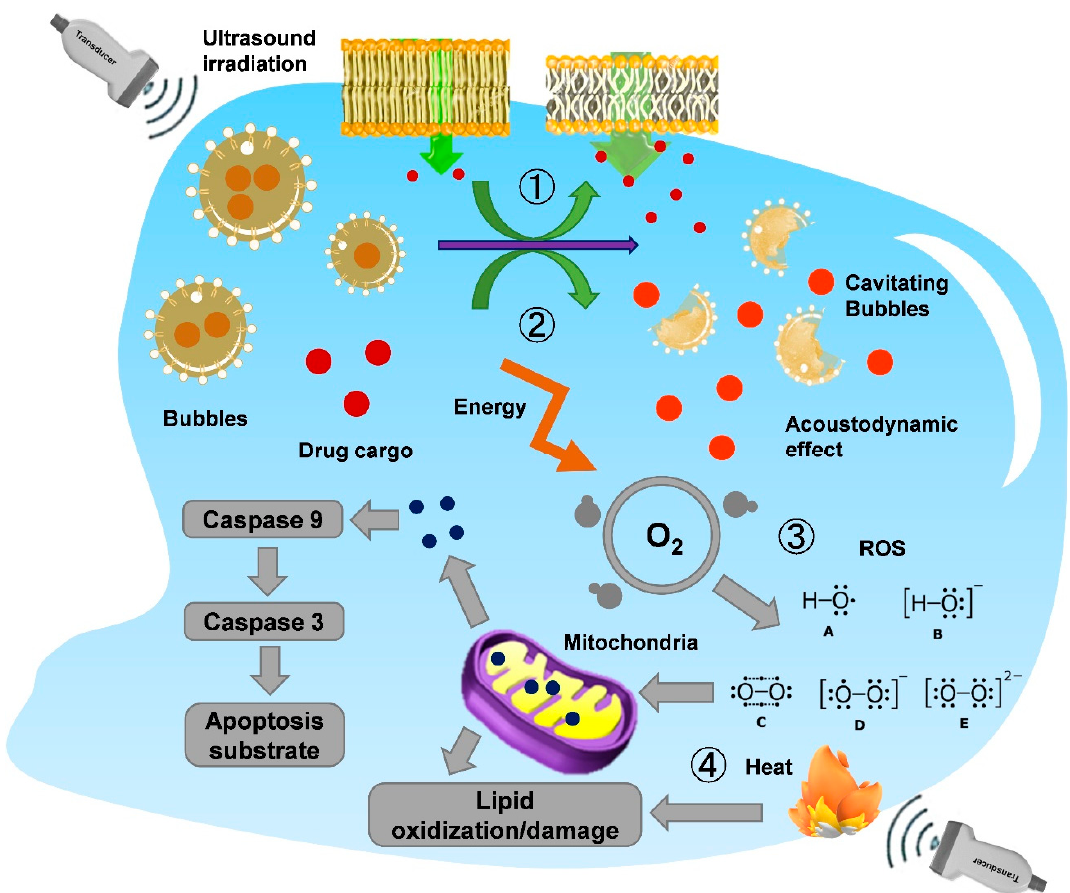
Figure 6. Schematic diagram of the various cellular change mechanisms induced by ultrasound. ① Cavitation caused by ultrasonic waves induces the rupture of bubble contrast agents in cells. ② Drug cargo is released, and acoustically powered drug delivery is provided. ③ Intracellular reactive oxygen species (ROS) may also be involved in cytotoxicity due to ultrasound excitation and generation. ROS-mediated mitochondrial membrane damage and the release of cytochrome c induce apoptosis. ④ There is also membrane damage due to the treatment with high-frequency sound waves since the unavoidable heat generation.